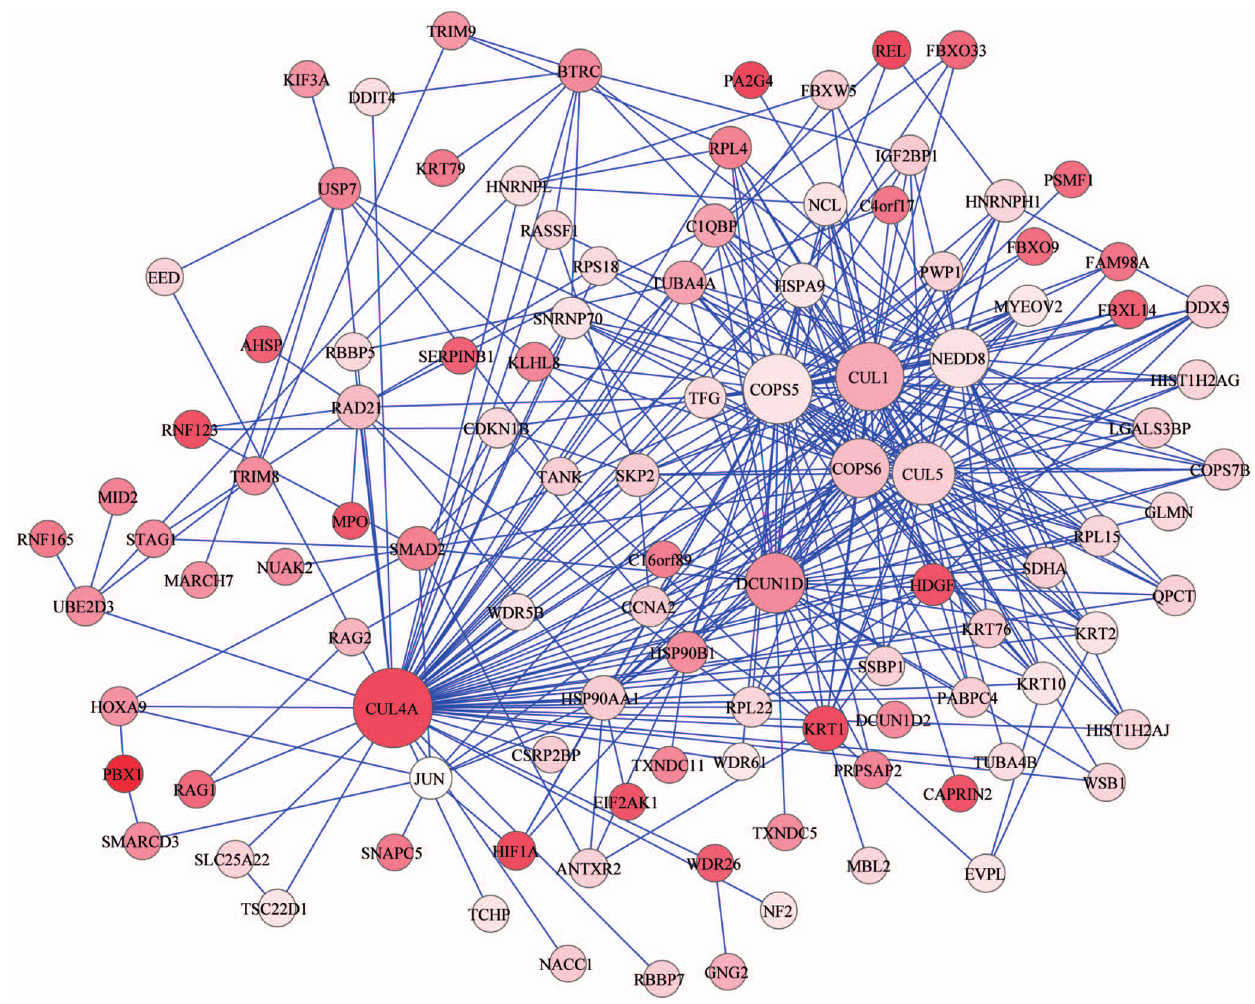
Figure 2. AF subnetwork derived from protein-protein interaction. Each node represents one gene, wheras each edge represents the interaction between two genes. The nodes were colored to represent their association with AF: red color represents strong association, and white color represents no association. The node size is proportional to the number of edges that the node connects to.